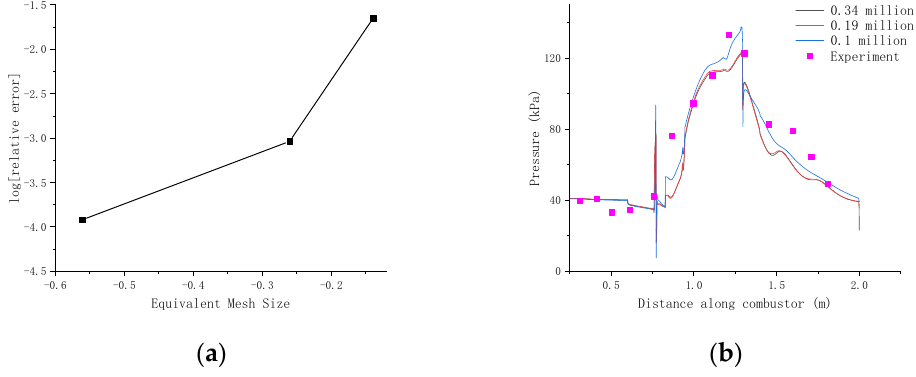
Figure 3. ( a ) Grid convergence behavior and ( b ) wall pressure with axial distance.